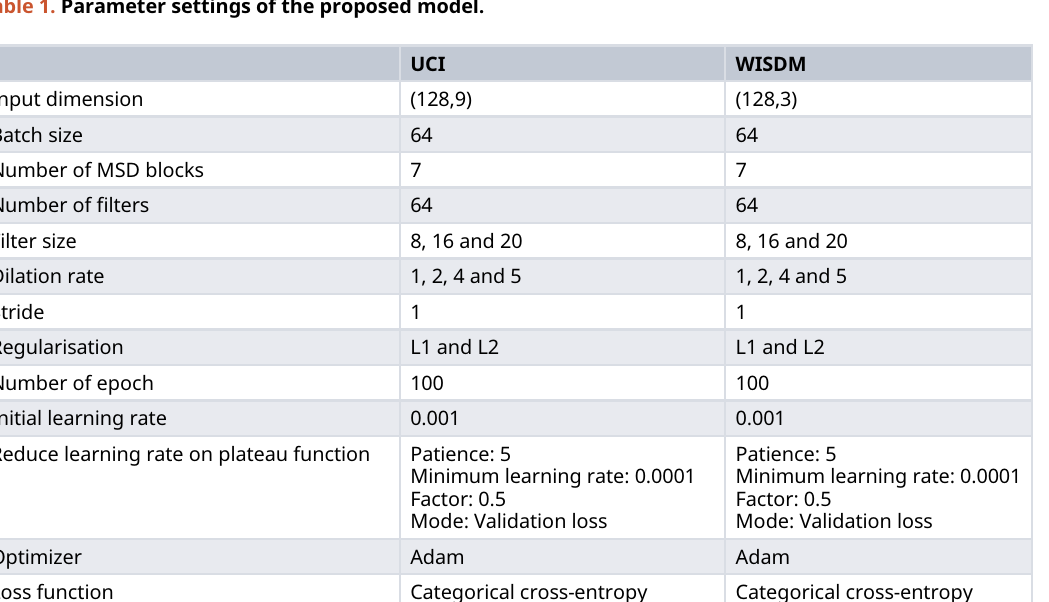
Table 1. Parameter settings of the proposed